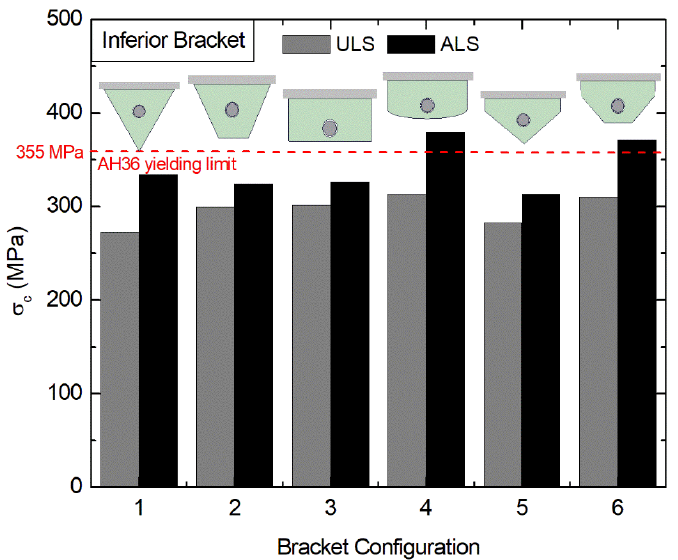
Figure 10. Maximum von Mises stress obtained in the inferior bracket for the six different geometric configurations under the ULS and ALS conditions.